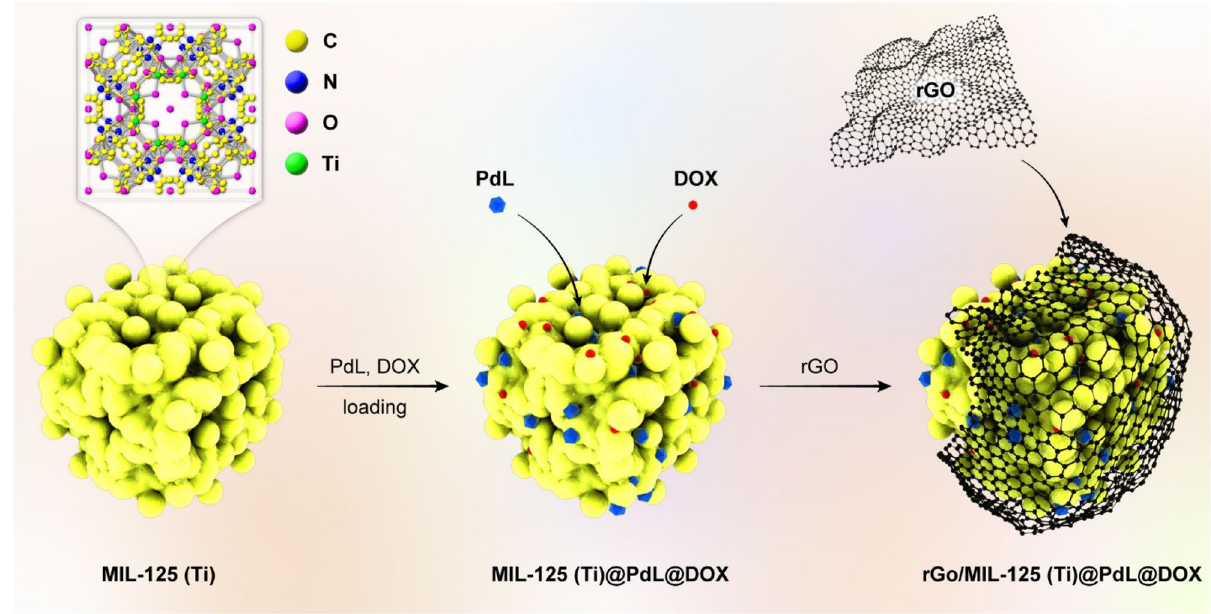
Figure 1. A schematic illustration of nanocomposite